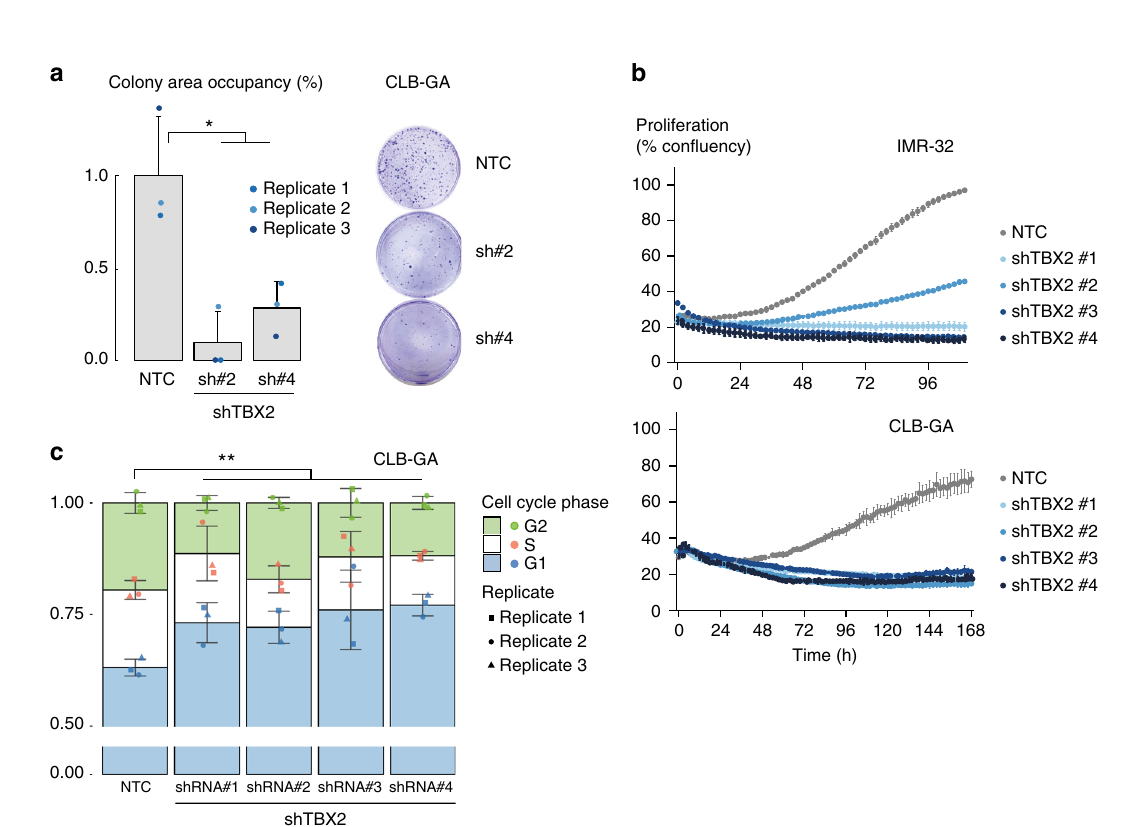
Fig. 5 TBX2 is a cell dependency gene in neuroblastoma. a Signi fi cant reduction in colony area occupancy (%) upon TBX2 knockdown as compared to the non-targeting control (NTC) in CLB-GA cells. b Reduction of proliferation in IMR-32 and CLB-GA cells upon TBX2 knockdown measured with time-lapse microscopy (every 2 – 3 h) using the IncuCyte device (one out of three biological replicates is shown). c Cell cycle analysis upon TBX2 knockdown in the CLB-GA cell line. Signi fi cant induction of G1 cell cycle phase arrest upon TBX2 knockdown (statistical test is based on G1 phase percentage). Data-points were mean-centered (a,c) and error bars represent the s.d. of three biological (a,c) or fi ve technical (b) replicates for every cell line. Mann – Whitney test * p < 0.05, ** p <